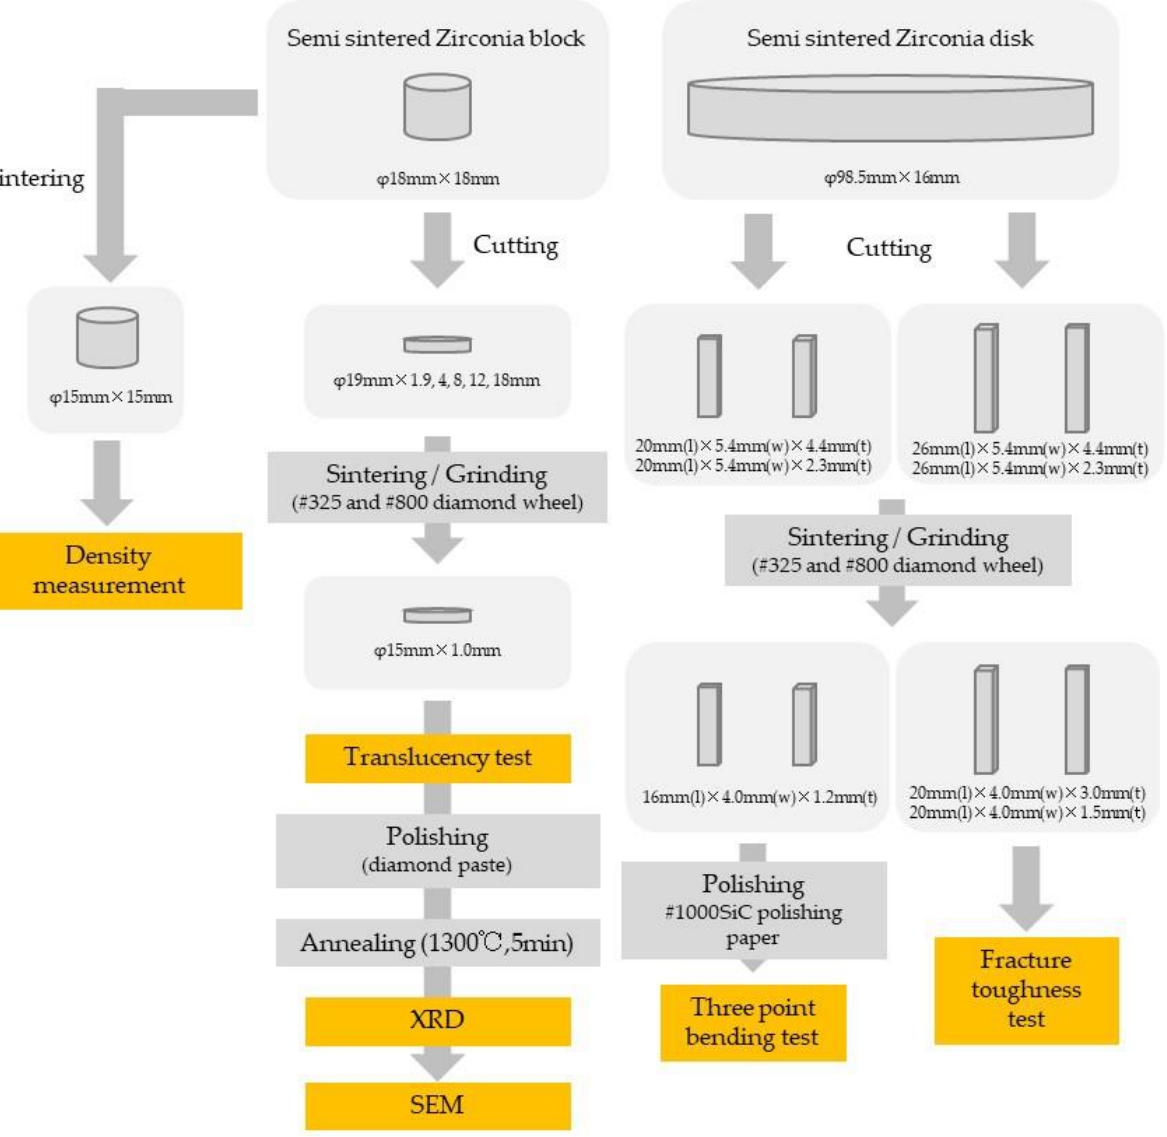
Figure 1. Specimen preparation flowchart and sample sizes (the mark “ ϕ ” denotes “diameter”). Table 1. Raw material powders and sintering methods of specimens. The number at the end of the specimen’s name indicates the thickness of the specimen before